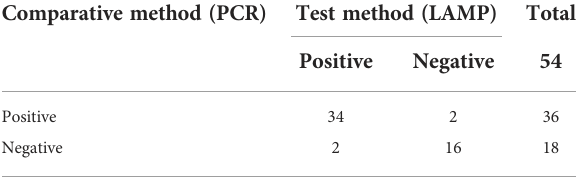
TABLE 5 Clinical sample test results by PCR and LAMP methods. Comparative method